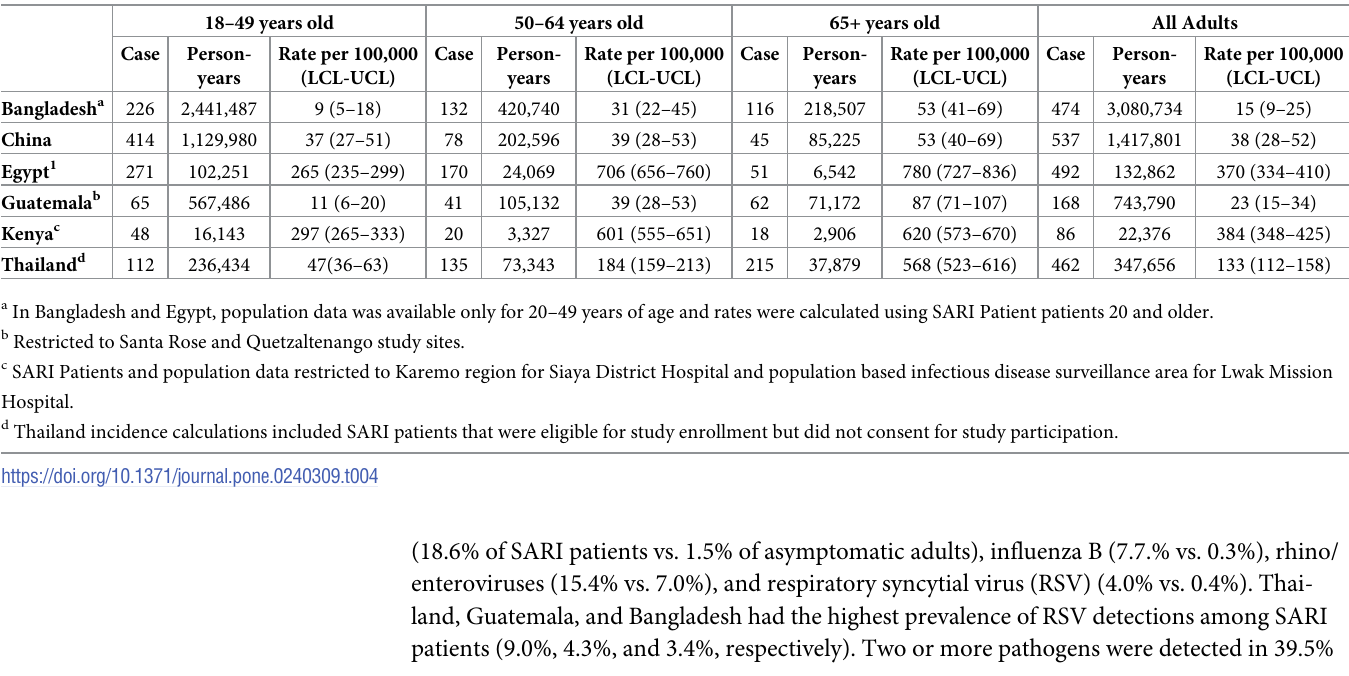
Table 4. Severe acute respiratory infection incidence rates, by participating site and age group.